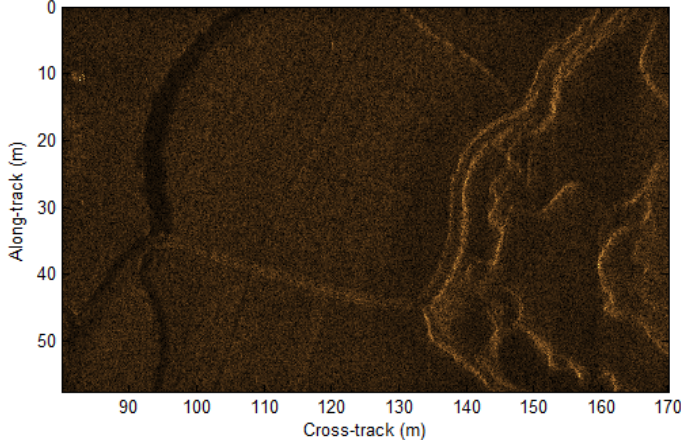
Figure 12. Real ‐ data processing result using nearest interpolation without upsampling. Figure 12. Real-data processing result using nearest interpolation without upsampling.